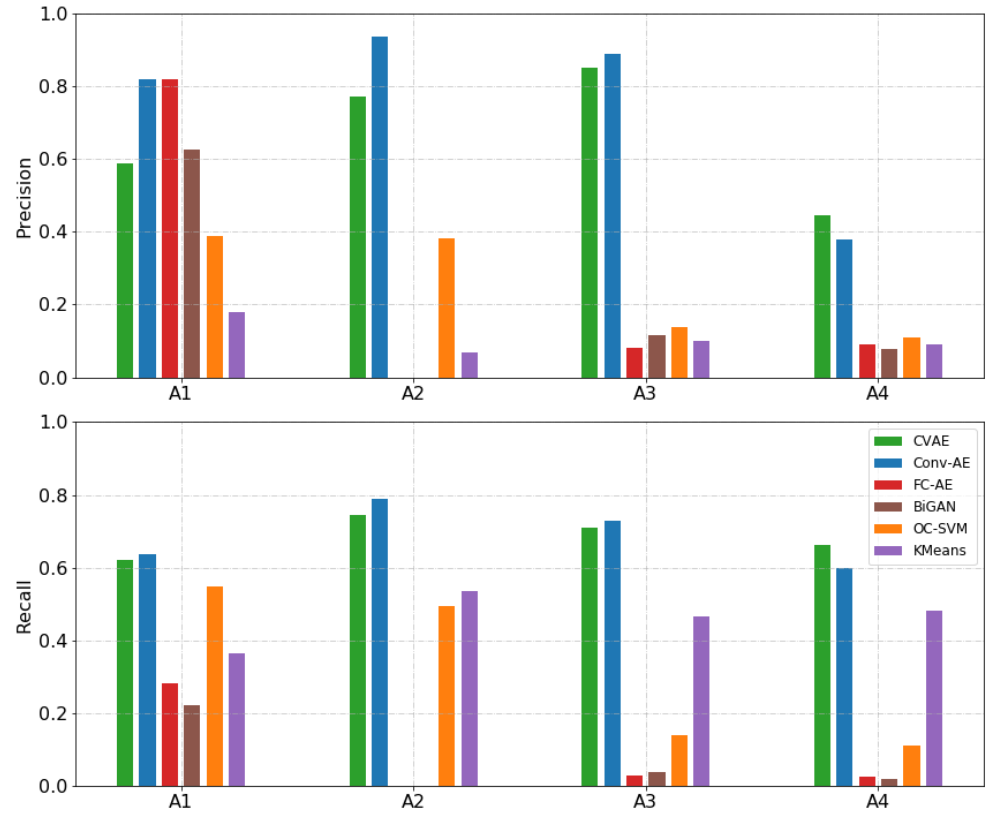
Figure 3. Anomaly detection in Yahoo!’s data using KMeans, OC-SVM, FC-AE, Conv-AE, CVAE, and BiGAN. It should be noted that FC-AE and BiGAN performances are absolute zero in the case of A2 data, since they both detect all of data in the testing set as